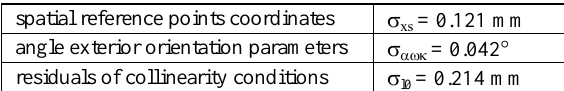
Table 1. Precision of interior